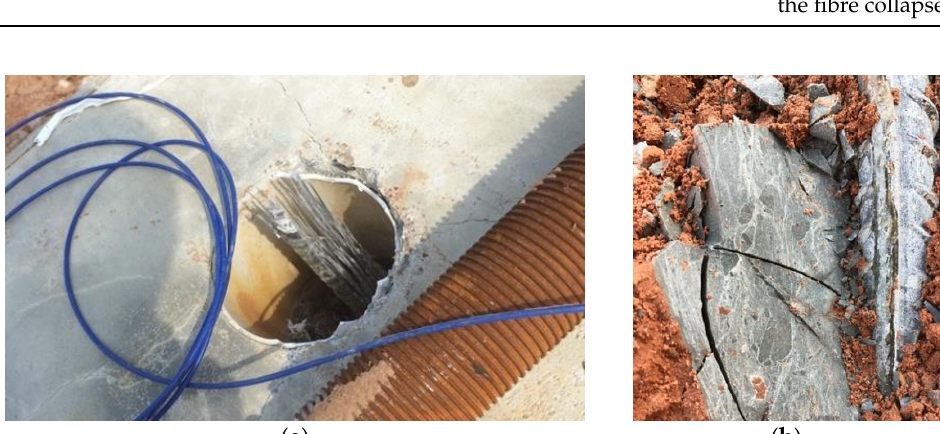
Figure 14. Failure mode of the bar body. ( a ) Failure mode of the GFRP bar ( b ) Failure mode of the steel bar.